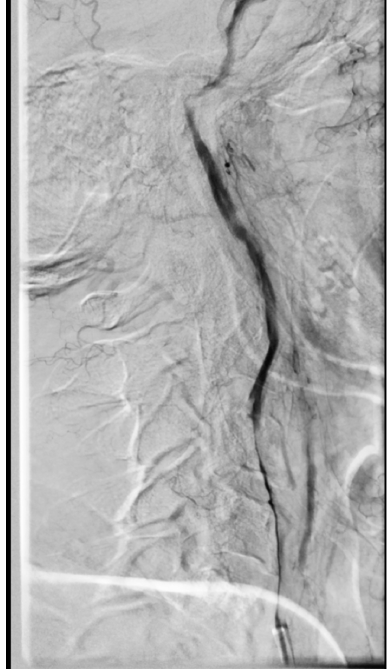
Figure 3. Right ICA, long dissection.